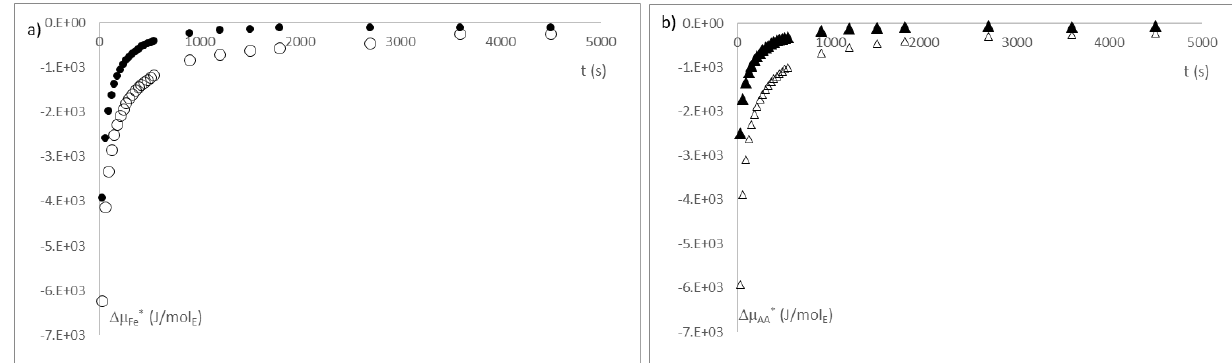
Figure 12. ( a ) Gradient of partial iron chemical potential and ( b ) gradient of partial ascorbic acid chemical potential in the bead –liquid phase interface. Where (●) is iron ion released at pH of 3; ( ○ ) is iron ion released at pH of 4.7; ( ▲ ) is ascorbic acid released at pH of 3 and (∆) is ascorbic acid released at pH of 4.7. Notation is according to IuPAC.